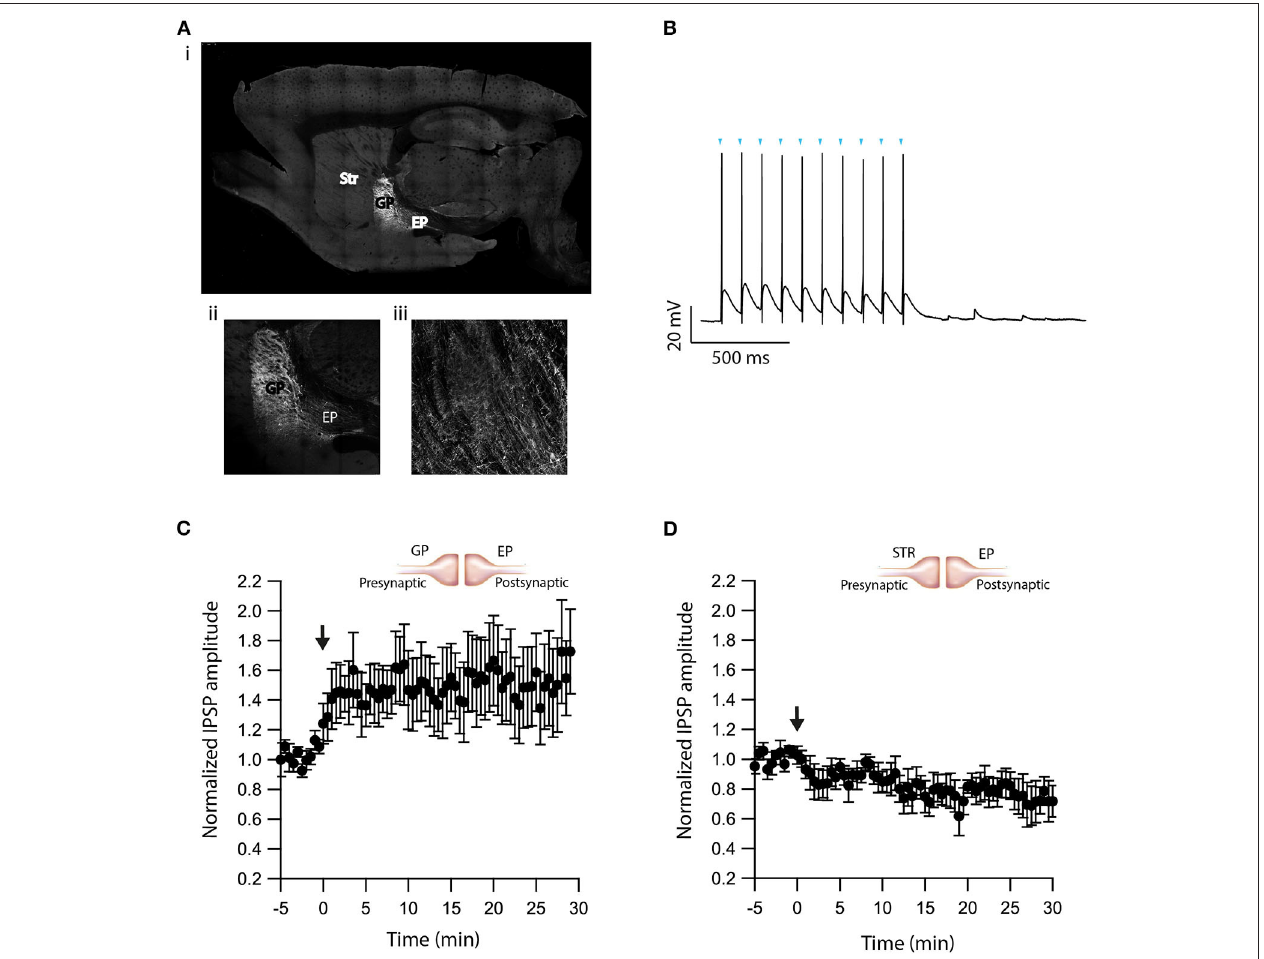
FIGURE 6 | Optogenetic verification of eCB induced plasticity. (A) Sagittal brain slice image containing the GP (the injected zone), the EP (the recording zone), and adjacent structures. ChR2-YFP expression was observed in infected cells in the GP and in axons terminals in the EP. The Image was magnified x10 (i), x20 (ii, iii). (B) Whole-cell recording from a ChR2 expressing GP neuron illuminated with a 10Hz light pulse train. The onset of light stimulation is indicated by inverted triangles. The EP neuron‘s membrane potential was set approximately to − 60mV by injecting positive or negative current ( ∼ 0–20pA). (C) Post-HFS stimulation of 100Hz for 10s induced LTP at GP-EP synapses ( n = 6). Normalized IPSP amplitudes (normalization to the mean amplitude of IPSP recorded during the beginning of baseline recordings) are plotted against time. The arrow indicates the time of depolarization induction protocol, and error bars represent the SEM. (D) Post-HFS stimulation